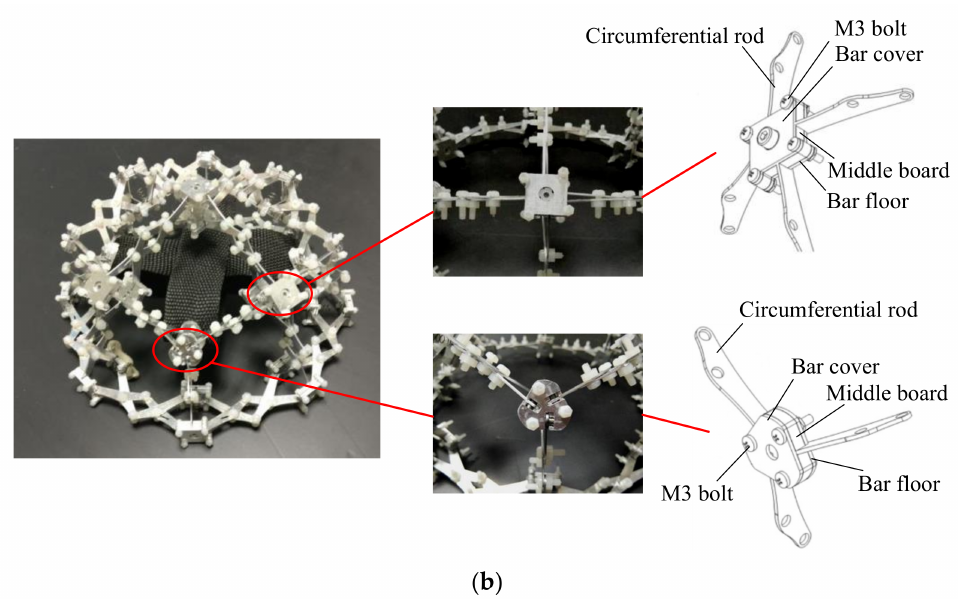
Figure 1. Variant truss beam structure: ( a ) Contracted state of the truss beam structure; ( b ) Expanded state of the truss beam structure and constituent elements.